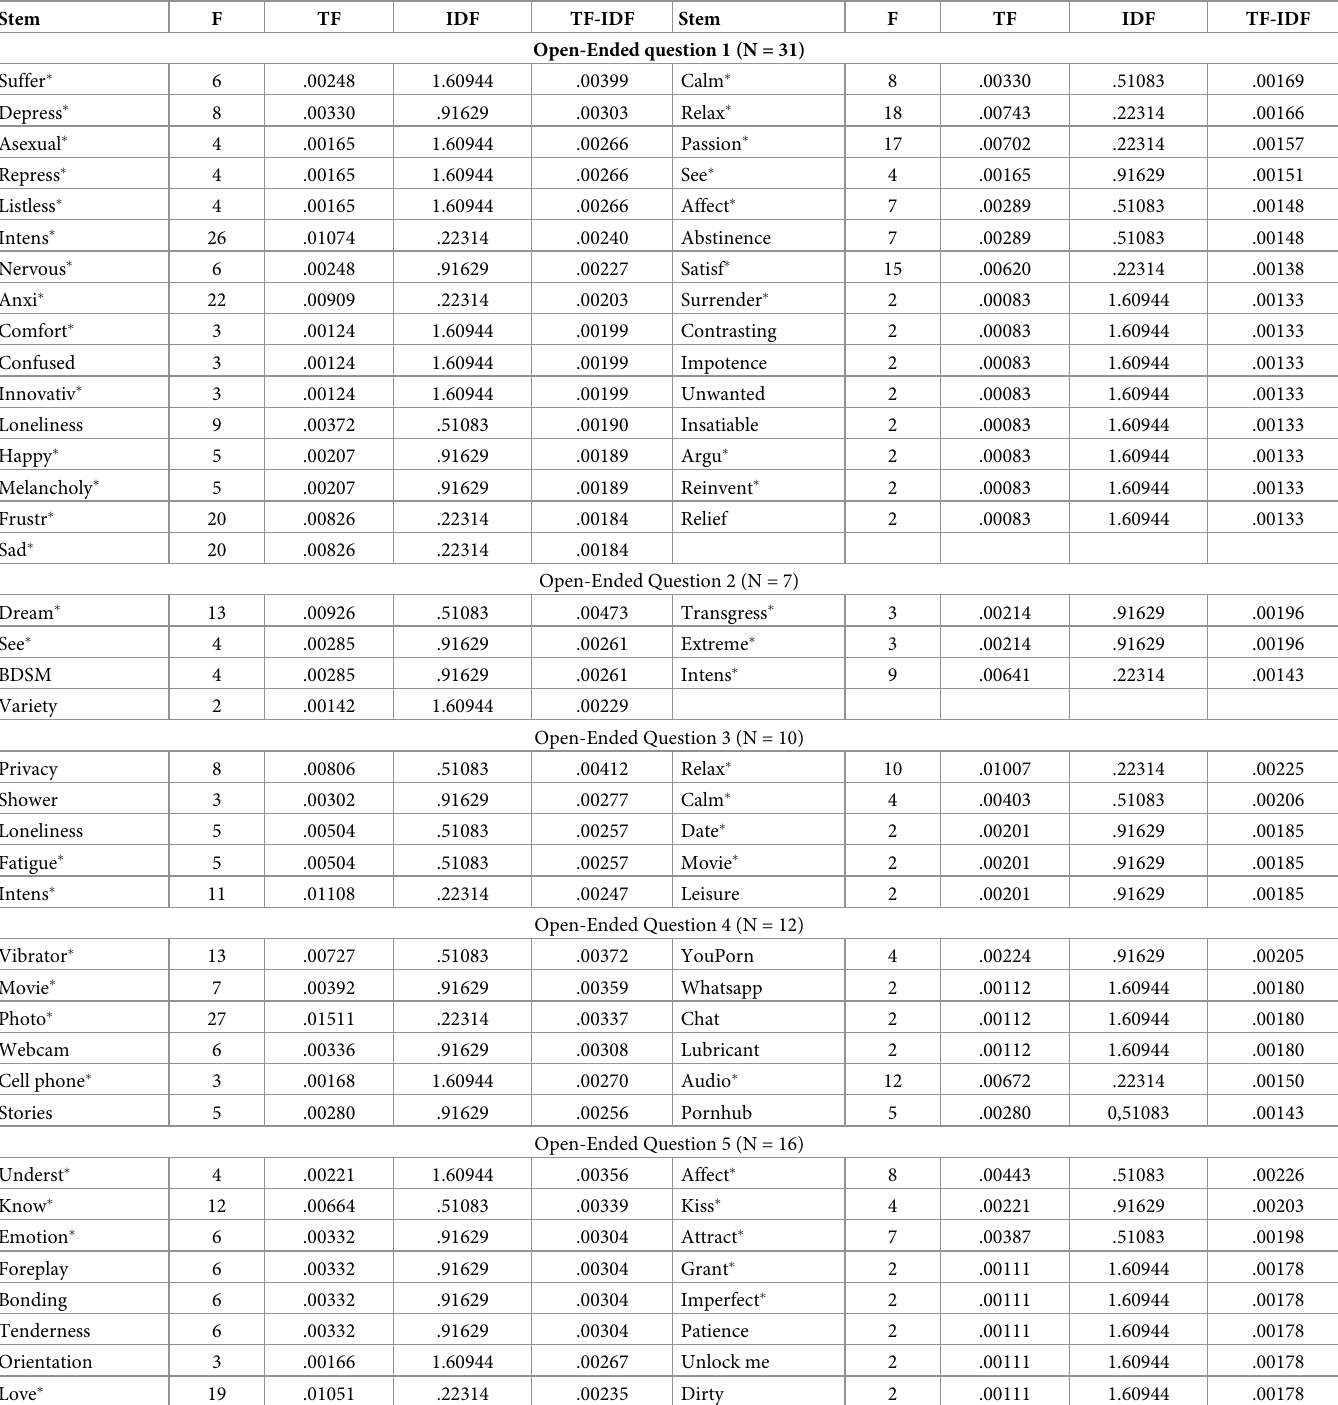
Table 5. Frequency data about the salient stems above the first (positive) standard deviation of the TF-IDF scores for each of the five open-ended questions.